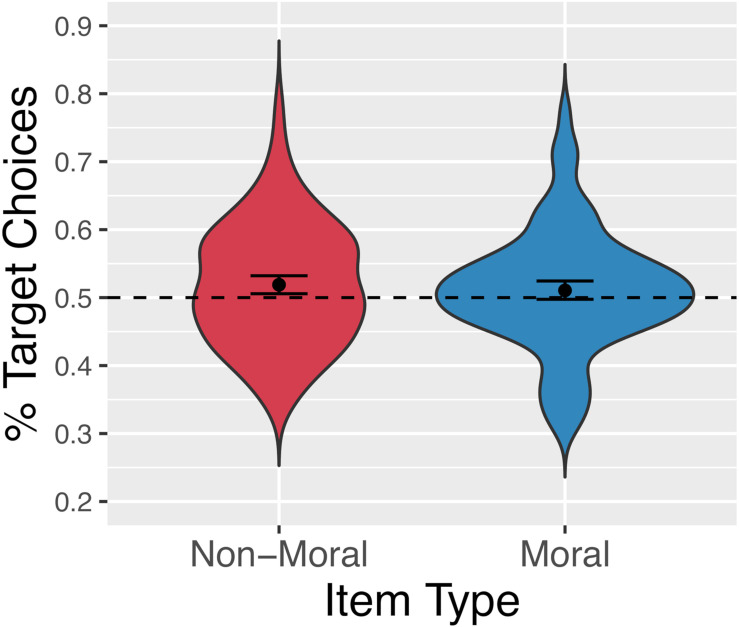
Percentage of trials on which participants selected the randomly pre-selected target option for non-moral (red, left) and moral (blue, right) statements.